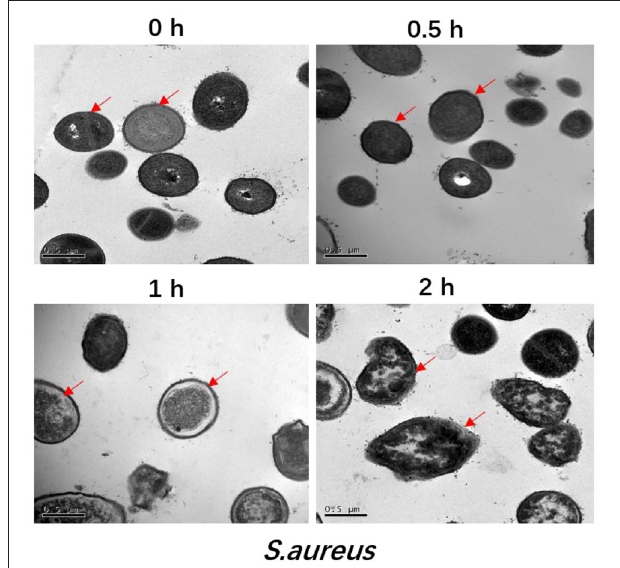
FIGURE 1 | Transmission electron microscopic analysis of S. aureus treated by 5 × MIC of antimicrobial peptide F1 for 0, 0.5, 1, and 2h, respectively. All images are representative of three independent experiments. The arrow is pointing a breakage in the